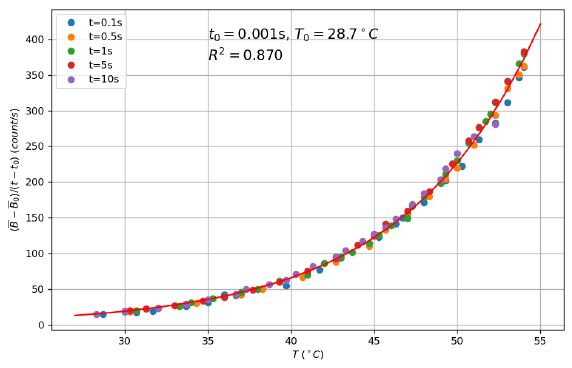
Figure 6. The regression curve for determining factor b . The coefficient of determination R 2 is presented.